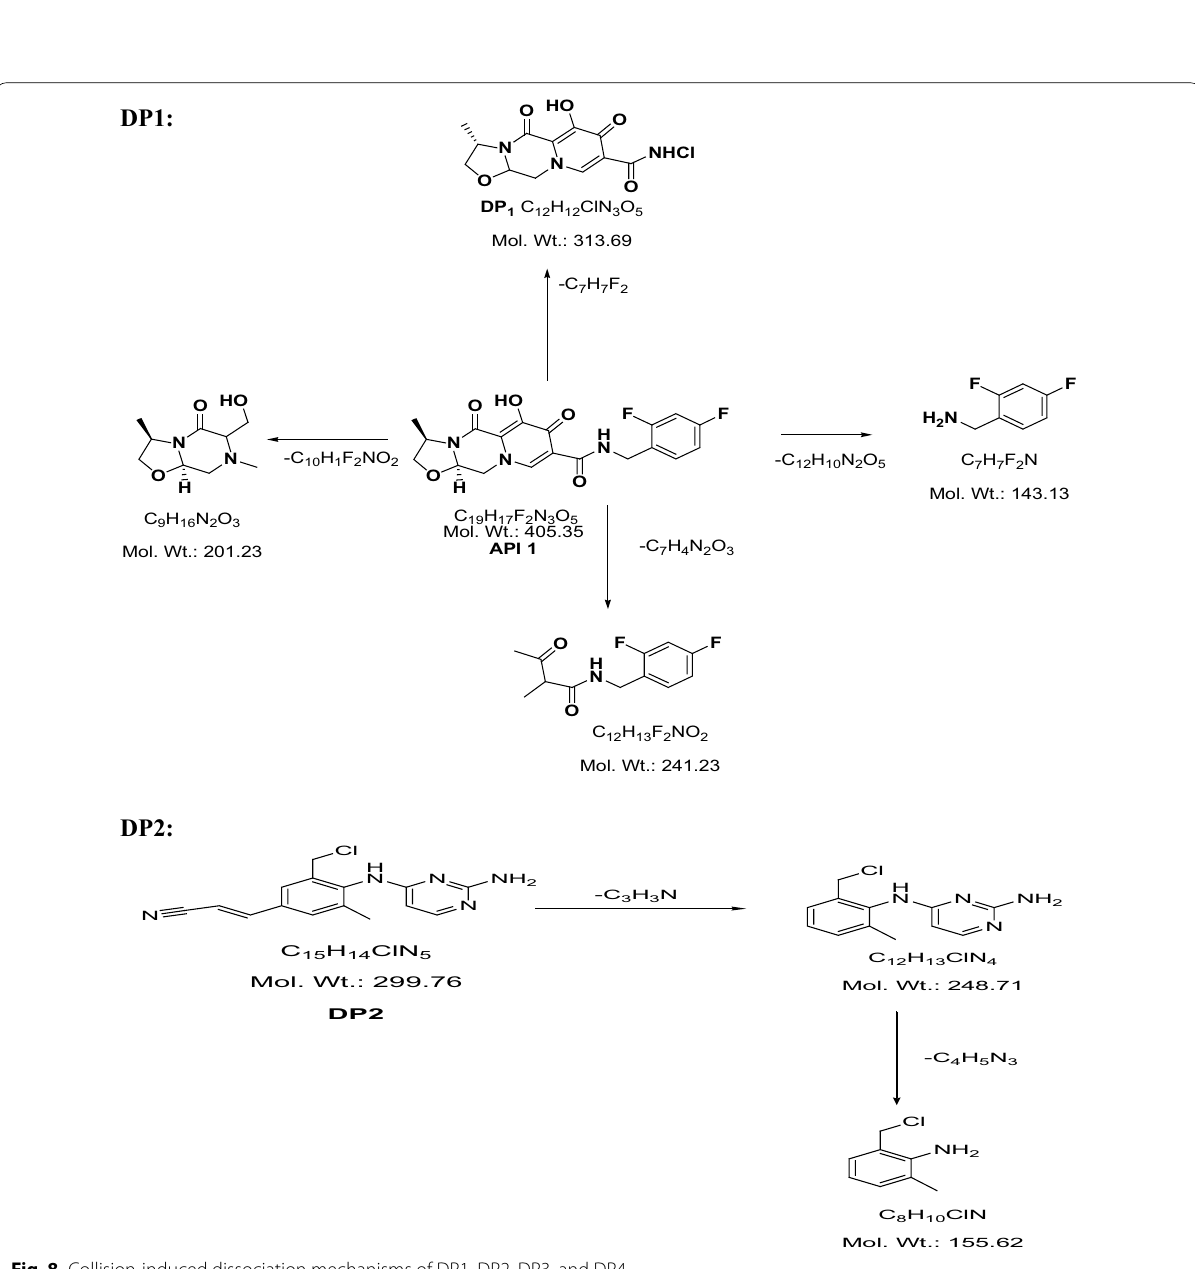
IR spectrum of DP3 showed at 3489.5 cm − 1 , 3357.1 cm − 1 indicates the presence of N–H stretching, 2257.3 cm − 1 belongs to C N stretching, 1727.6 cm − 1 belongs to C ≡ stretching in amides, 3222.8 cm − 1 C–H alkene stretching and 2897.8 indicates C–H aliphatic